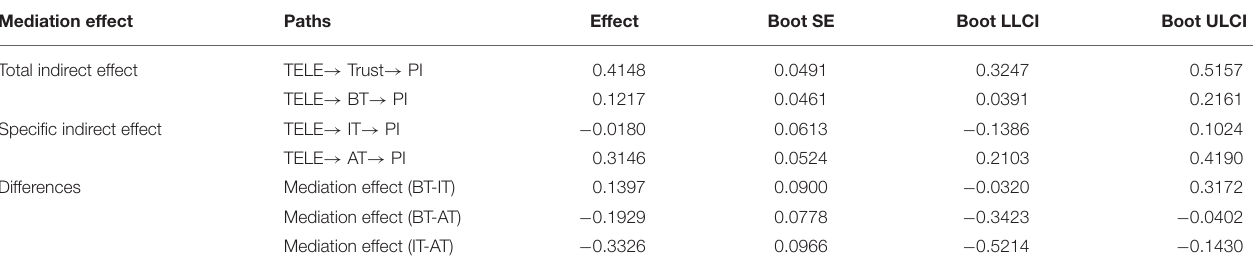
TABLE 4 | The total indirect effects and specific indirect effects ( N = 406).